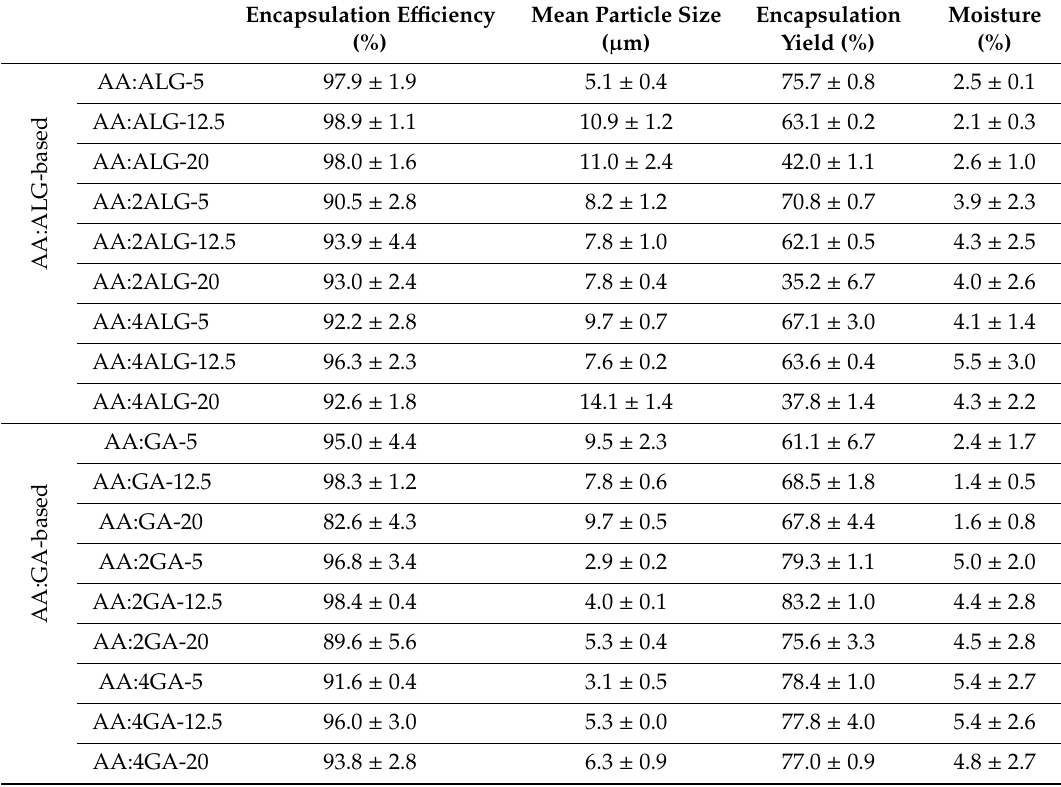
Table 2. AA encapsulation e ffi ciency (%), mean particle size ( µ m) encapsulation yield (%) and moisture (%) for AA:ALG and AA:GA-based